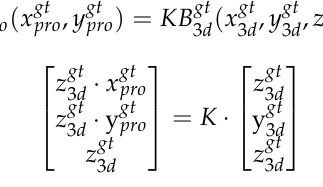
Figure 4. Difference between the projected point of the center point of the 3D box and the center point of the 2D box. point of the 2D